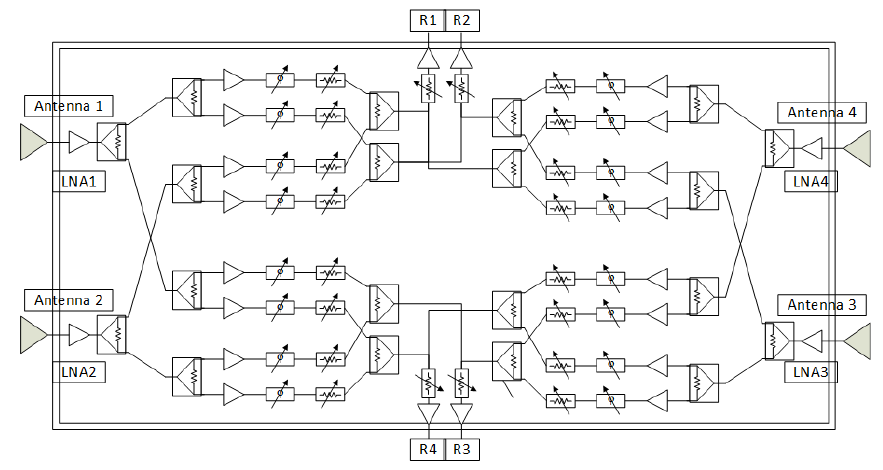
Figure 9. Block diagram of the amplitude-phase control